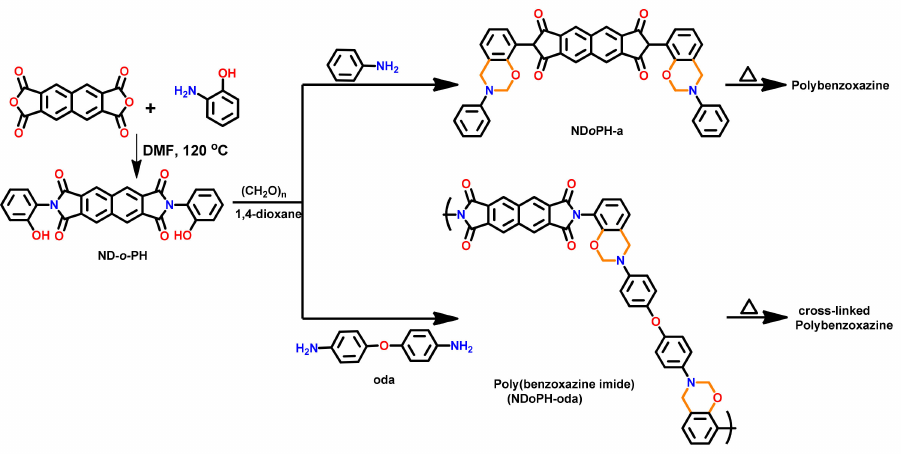
Figure 65. Synthesis of o -imide functional bisbenzoxazine monomer and main-chain type polyben- zoxazine oligomers